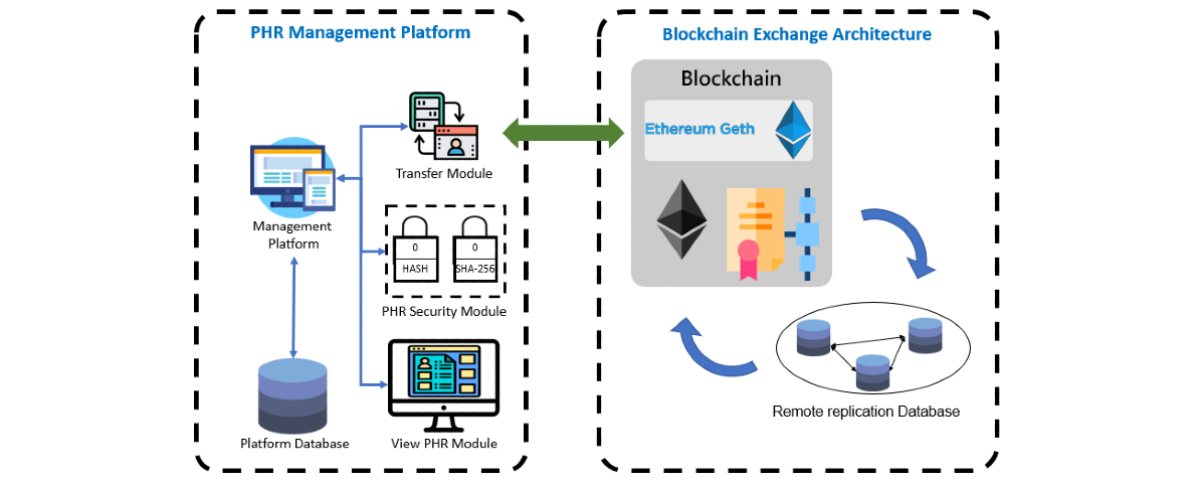
Figure 1. Personal health record management platform and blockchain architecture. PHR: personal health